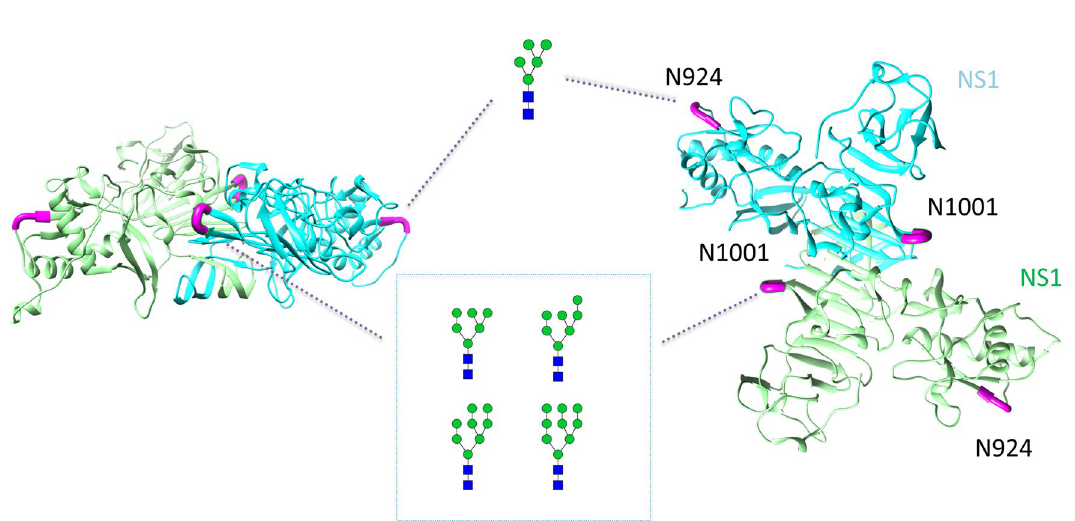
Figure 2. Site-specific N -glycosylation of the NS1 protein of ZIKV produced in EB66 cells. The structure of the homodimer NS1 (PDB: 5k6k) is exemplary illustrated. Monomers are visualized using different colors (green and cyan). Potential N -glycosylation sites are highlighted in magenta. Annotated N -glycans represent only possible N -glycan structures based on our results obtained by MS spectra analysis. Symbolic representation of N -glycan structures was generated with GlycoWorkbench Version 1.1 following the guideline of Symbol Nomenclature for Graphical Representation of Glycans 31